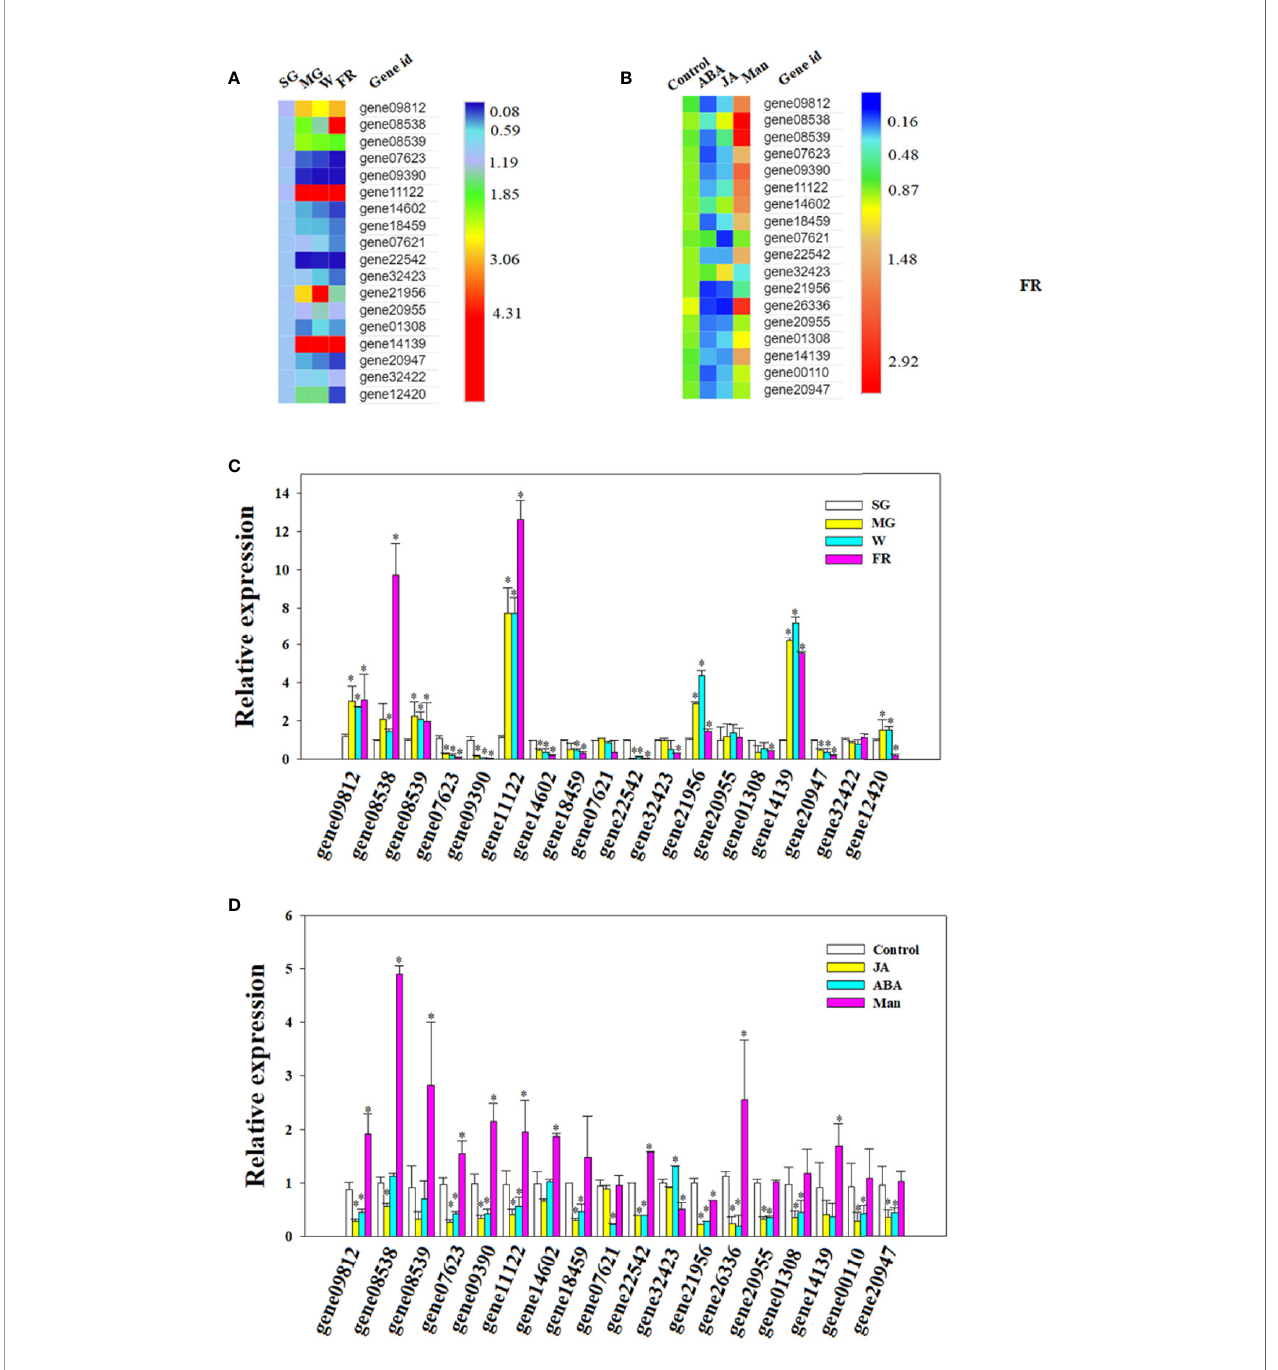
FIGURE 5 | Osmotin-like protein (OLP) expression during fruit development or in response to phytohormones and decrease in osmotic potential (DOP). (A, B) Heatmap showing the pattern of gene expression as analyzed by quantitative real time (qRT)-PCR (C, D) . Numbers on the right side of the bars denote the fold changes. For abscisic acid (ABA), jasmonic acid (JA) and mannitol treatments (Man), the receptacles at the LG stage were cut into slices and incubated in 100 µM ABA, 100 µM Me-JA or 0.65 M mannitol for 6 h. Controls were SG for the developmental stage incubation in double distilled water (DDW) for the phytohormone and DOP treatments. qRT-PCR values were normalized to the expression value for FaACTIN and expressed as fold changes compared to the control. Bars are the mean ± SD of 3 biological replicates. Asterisks denote signi fi cant differences compared with the control at *P < 0.05, according to a Student ’ s t -test. SG, small green; LG, large green; MG, middle green; W, white and FR, full